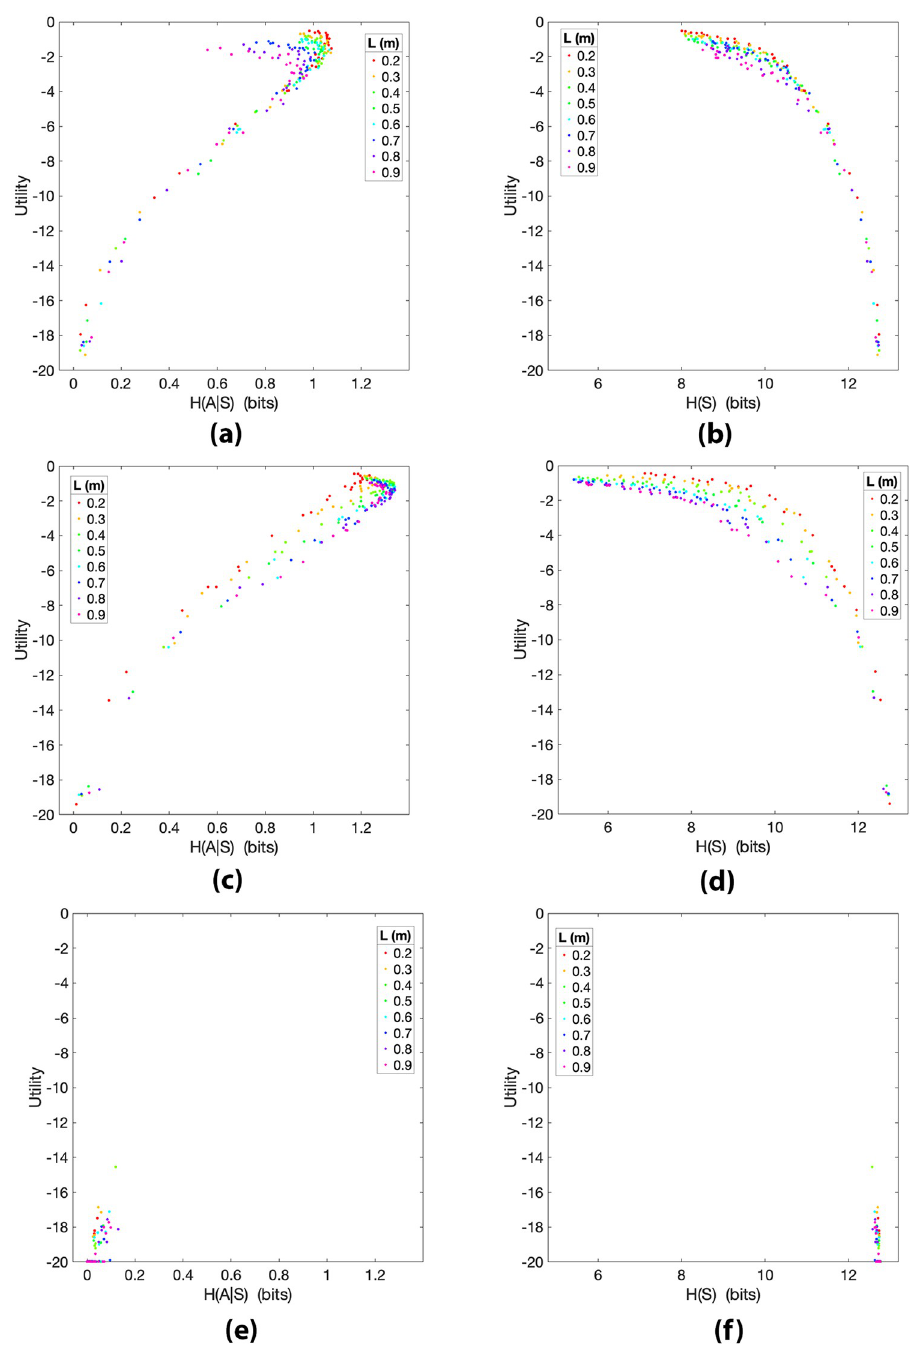
Fig 13. Utility U j of simulations j plotted as a function of H ( A j | S j ) ((a,c,e)) and H ( S j ) ((b,d,f)) for all pendulum lengths L and artificial controllers with different observation disturbances η and transition disturbances δ . (a) Observation standard deviations s O correlation ρ = 0.694 ( p < 0.01). (b) s O